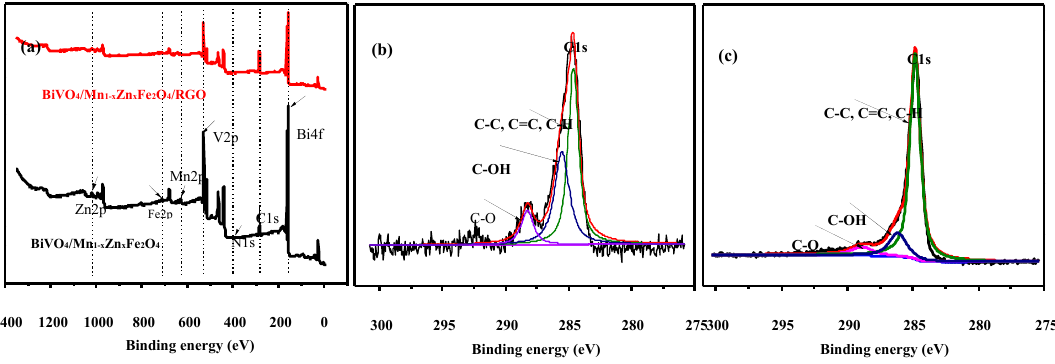
Figure 3. XPS survey spectra of ( a ) full range scan of BiVO 4 /Mn 1 − x Zn x Fe 2 O 4 and BiVO 4 /Mn 1 − x Zn x Fe 2 O 4 /RGO; ( b ) C1s peaks in BiVO 4 /Mn 1 − x Zn x Fe 2 O 4 ( c ) C1s peaks in BiVO 4 /Mn 1 − x Zn x Fe 2 O 4 /RGO.